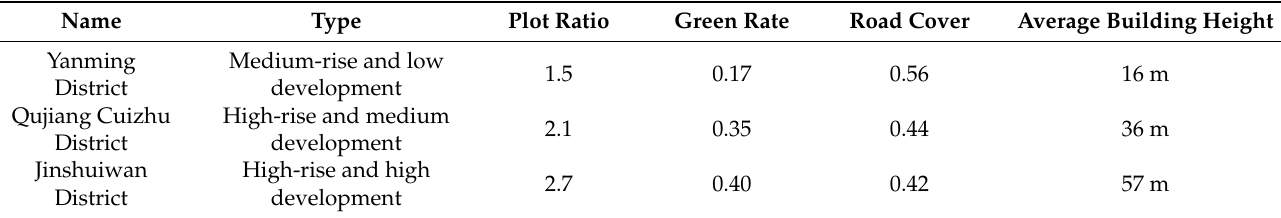
Table 1. Basic information of three selected